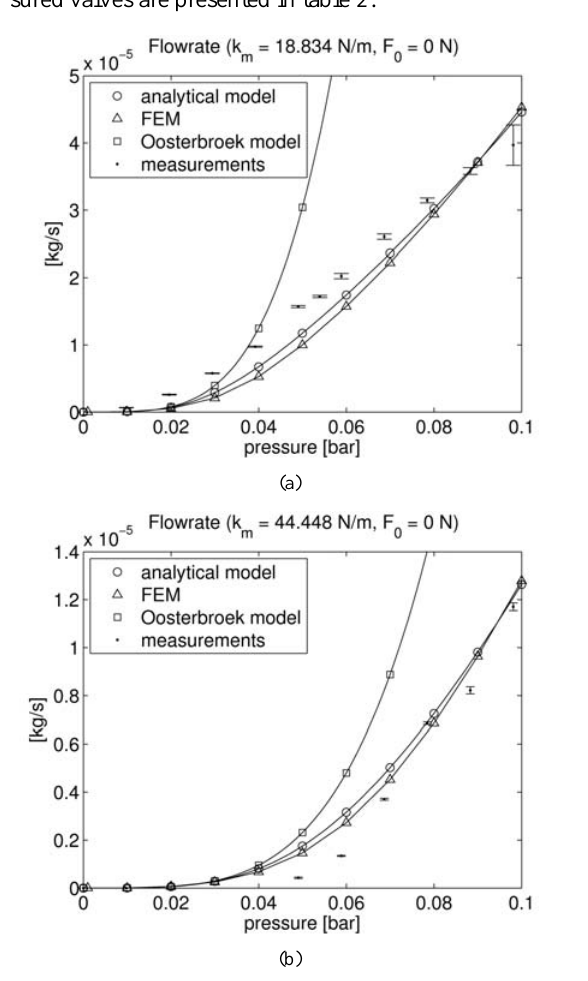
Fig. 8: Validation of the model for two sets of parame- ters. Graphs shows the flowrate through the valve versus the inlet pressure.